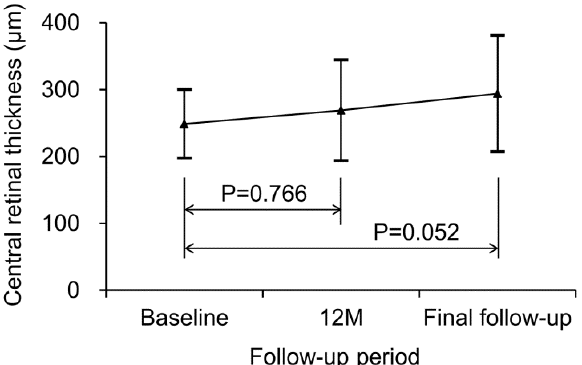
Figure 3. Changes in central retinal thickness (CRT) during the follow-up period. Statistical analysis was performed using the Wilcoxon signed-rank test with Bonferroni’s correction.